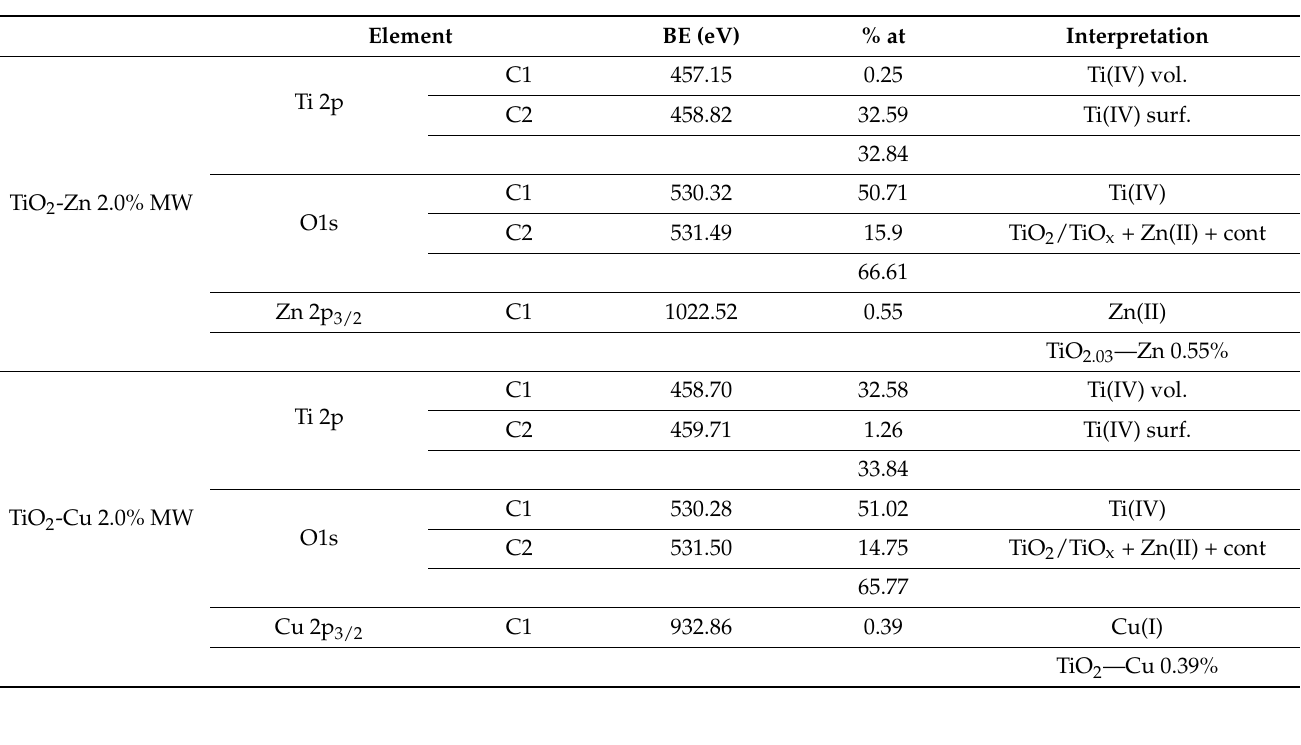
Table 2. Binding energies (BE), atomic %, and attributions of the deconvolutions for the core levels for the as-prepared samples.